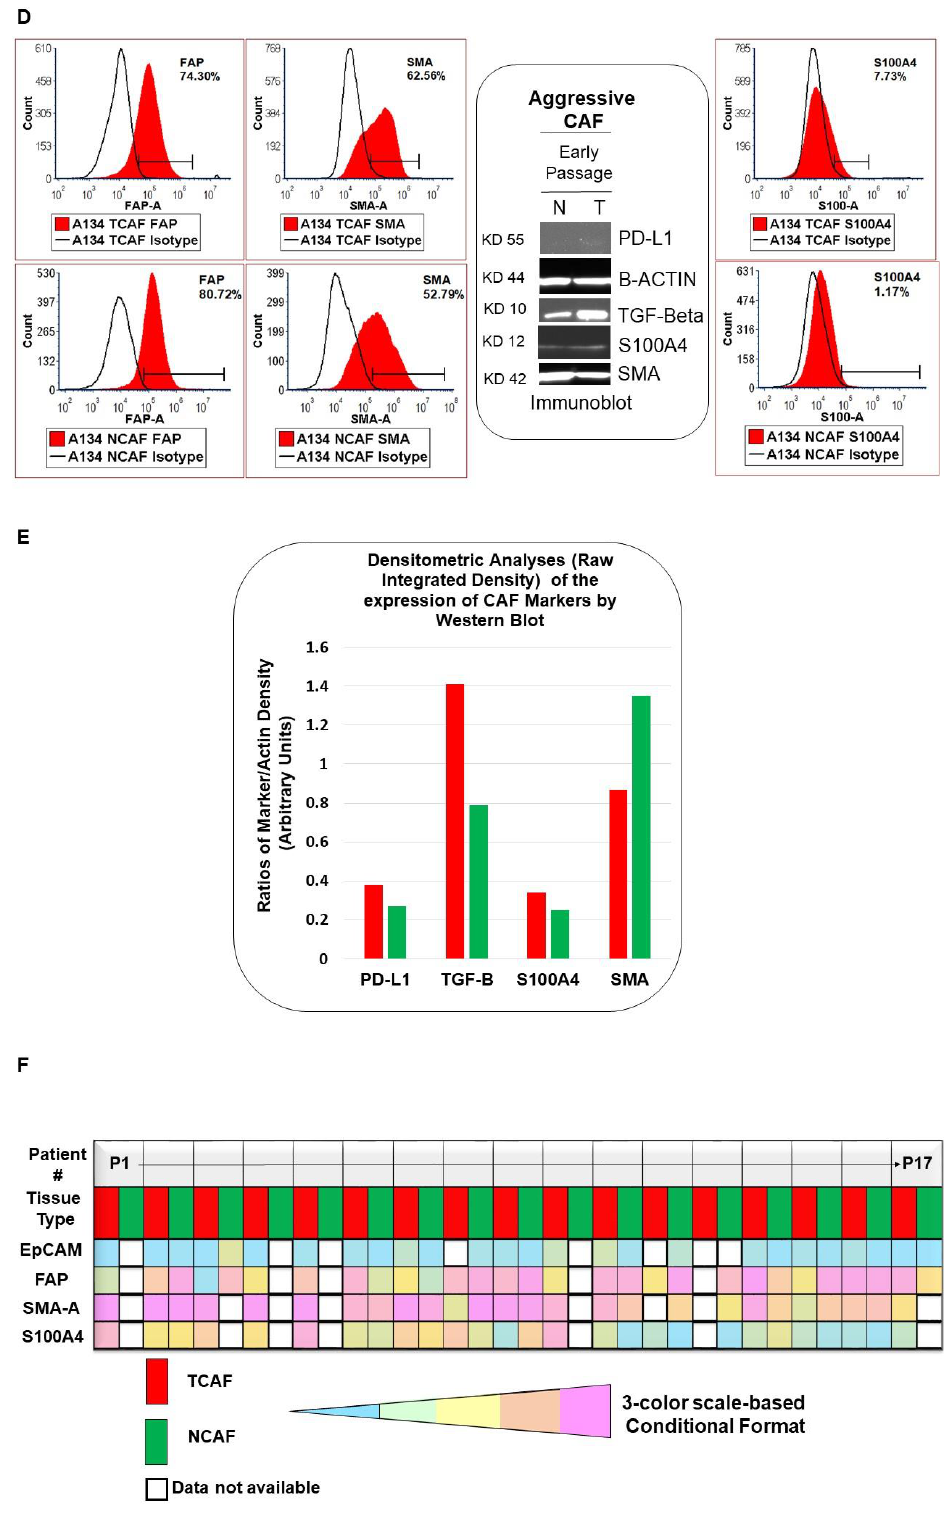
Figure 2. Expression of marker proteins of CAF by flow cytometry: Expression of the six positives (CD155, CD90, SMA-A, S100A4, FAP-A) and two negatives (EpCAM and CD31) markers of CAF in the established TCAFs and NCAFs from the T and TAN samples from two patients; one bearing non-aggressive CAFs ( A , B ) and bearing aggressive CAFs ( C , D ) by flow cytometry. ( D ) compares the flow cytometry expression of SMA and S100A with the WB expression (inset) of SMA and S100A from the same representative aggressive CAFs (TCAF and NCAF). The expressions of PD-L1, and TGFB, by WB, are also presented. The protein expression of the same markers (SMA and S100A4) by WB (inset) from a representative aggressive early passage NCAF and TCAF . The expressions of